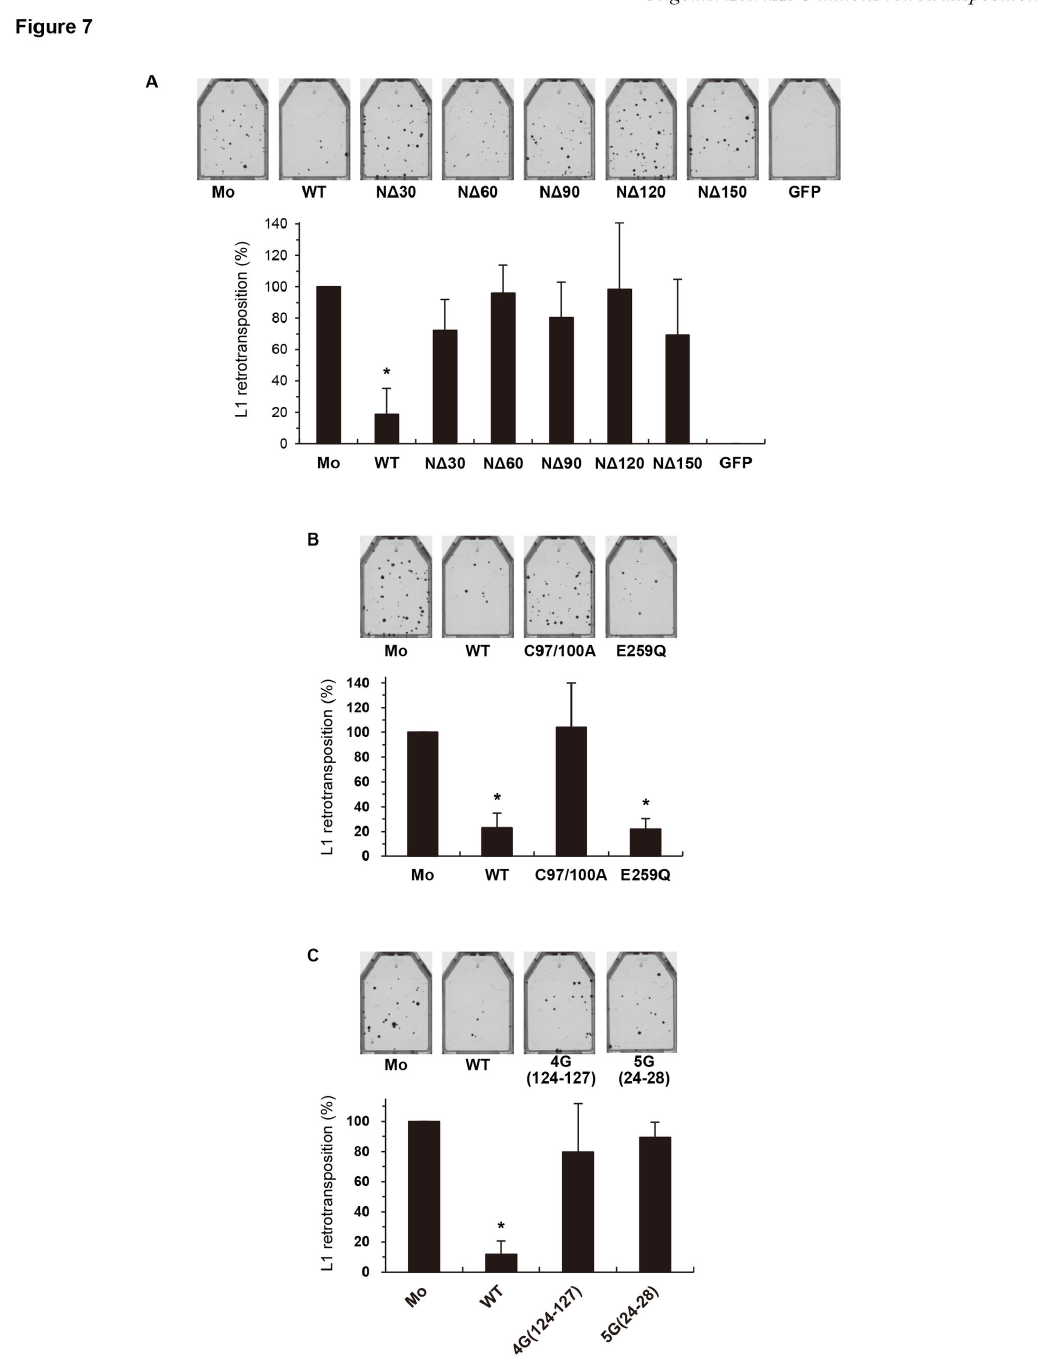
Figure 7. The oligomerization of hA3G is also associated with its anti-L1 activity. HeLa cells were cotransfected with the neo r -based L1 expression vector pCEP4/L1mneoI/ColE1 and either a wild-type (WT) or mutant hA3G expression plasmids. Seventy-two hours later, cells were trypsinized, re-seeded into T25 or T75 flasks, and subjected to G418 (1 mg/ml) selection. At 14 days after selection, the resultant G418 R colonies fixed, stained with crystal violet, and counted to determine the level of L1 retrotransposition. ( A ) Compare the results with Figure 2D and 2E. ( B ) Compare the results with Figure 3C and 3D. ( C ) Compare the results with Figure 6H. The data shown are the mean ± SD of triplicate experiments. Mo, mock; WT, wild-type hA3G; GFP, GFP only. * P < 0.005, t -test. doi: 10.1371/journal.pone.0084228.g007 PLOS ONE |